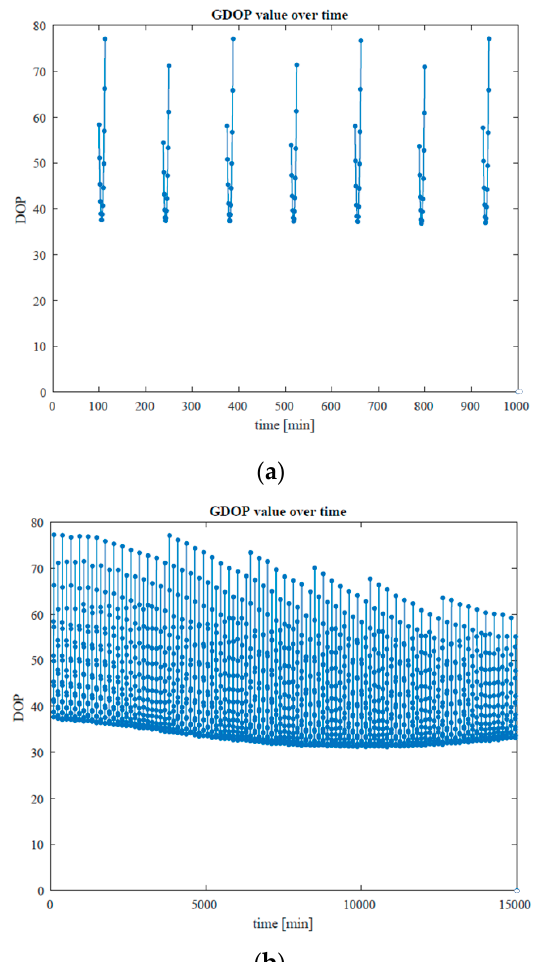
Figure 6. GDOP history over the course of the simulation period. ( a ) for 1000 min (closer look), ( b ) for 15,000 min (overall). Unless both satellites are in view, DOP is not calculated and not shown in the figures.